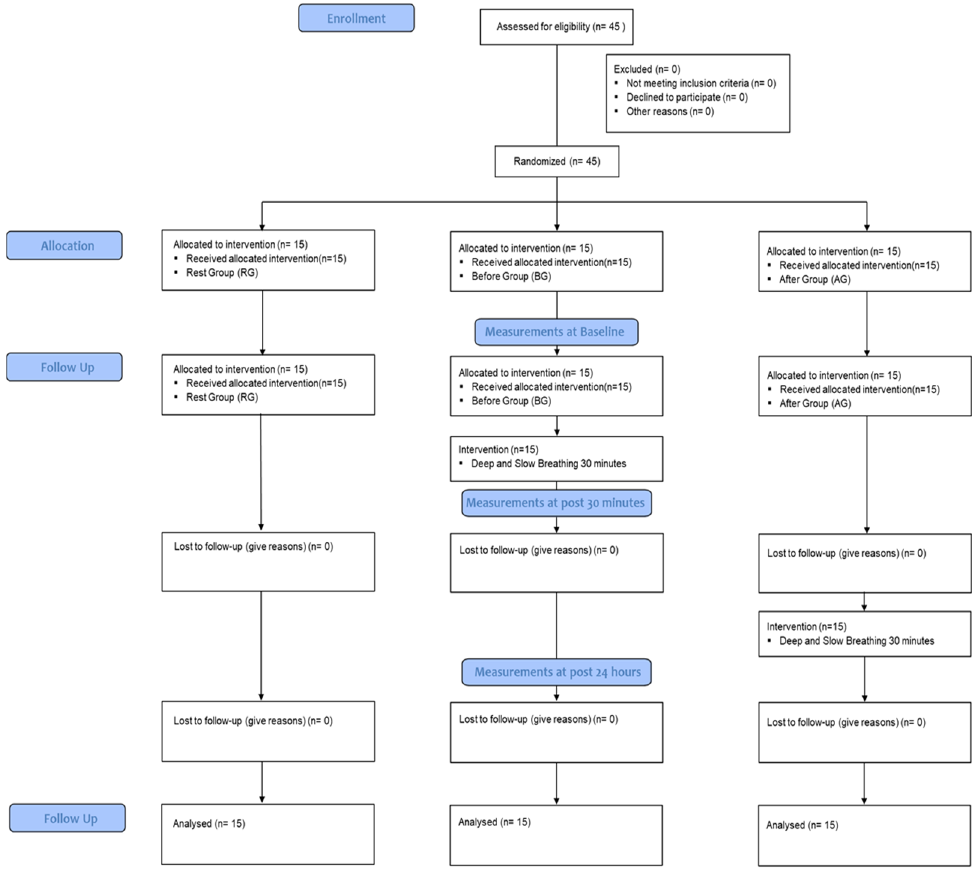
Figure 1. Flow chart.